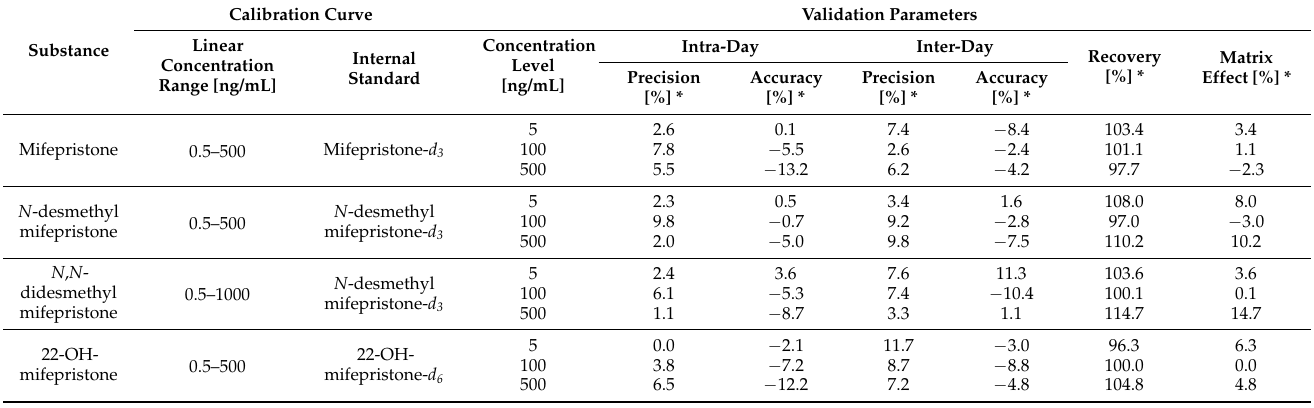
Table 3. Calibration curve and validation parameters of the UHPLC-QqQ-MS/MS method for determination of mifepristone with metabolites in whole blood samples.